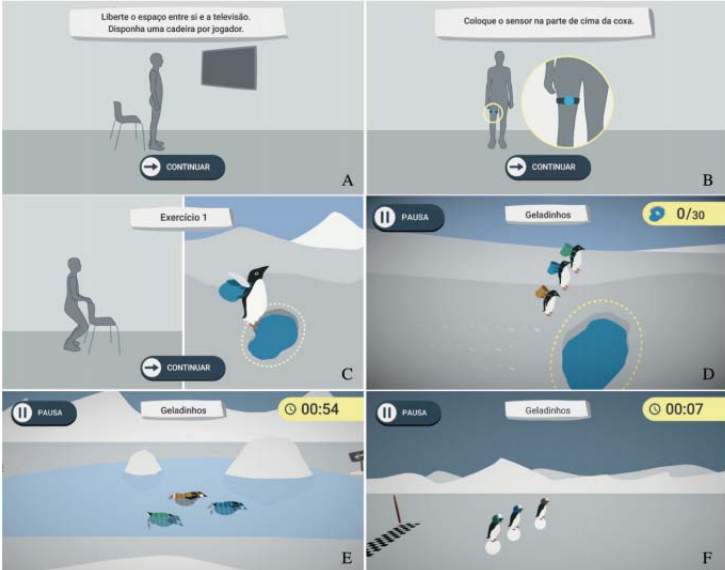
Figure 1. ( A ) Instructions on the space required to perform exercise; ( B ) Instructions on how to fix the sensor; ( C ) Exercise instructions; ( D ) Mini ‐ game 1; ( E ) Mini ‐ game 2; ( F ) Mini ‐ game 3 (Source: